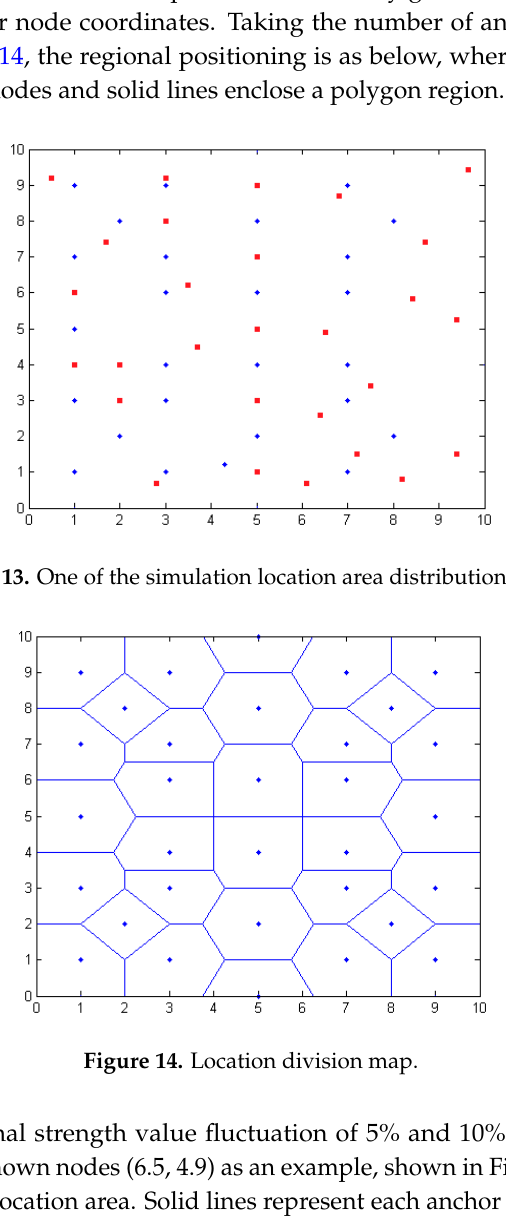
Figure 15. Region division positioning result. Table 3. The localization results with RSSI fluctuating 5%. Polygon Area Estimated